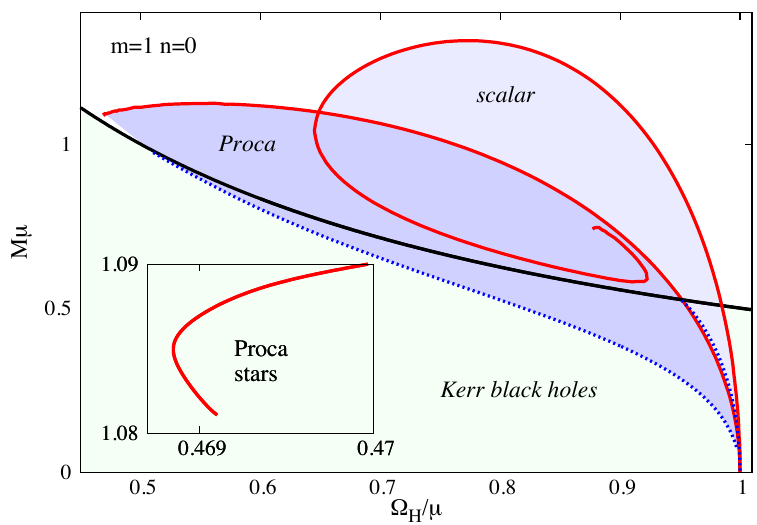
Figure 4 . Similar representation of the domain of existence as in (cid:12)gure 3, but now comparing the ( n; m ) = (0 ; 1) (fundamental states) Kerr BHs with synchronised scalar and Proca hair. The inset shows a detail of the backbending of the fundamental Proca stars line, as it attains the minimal